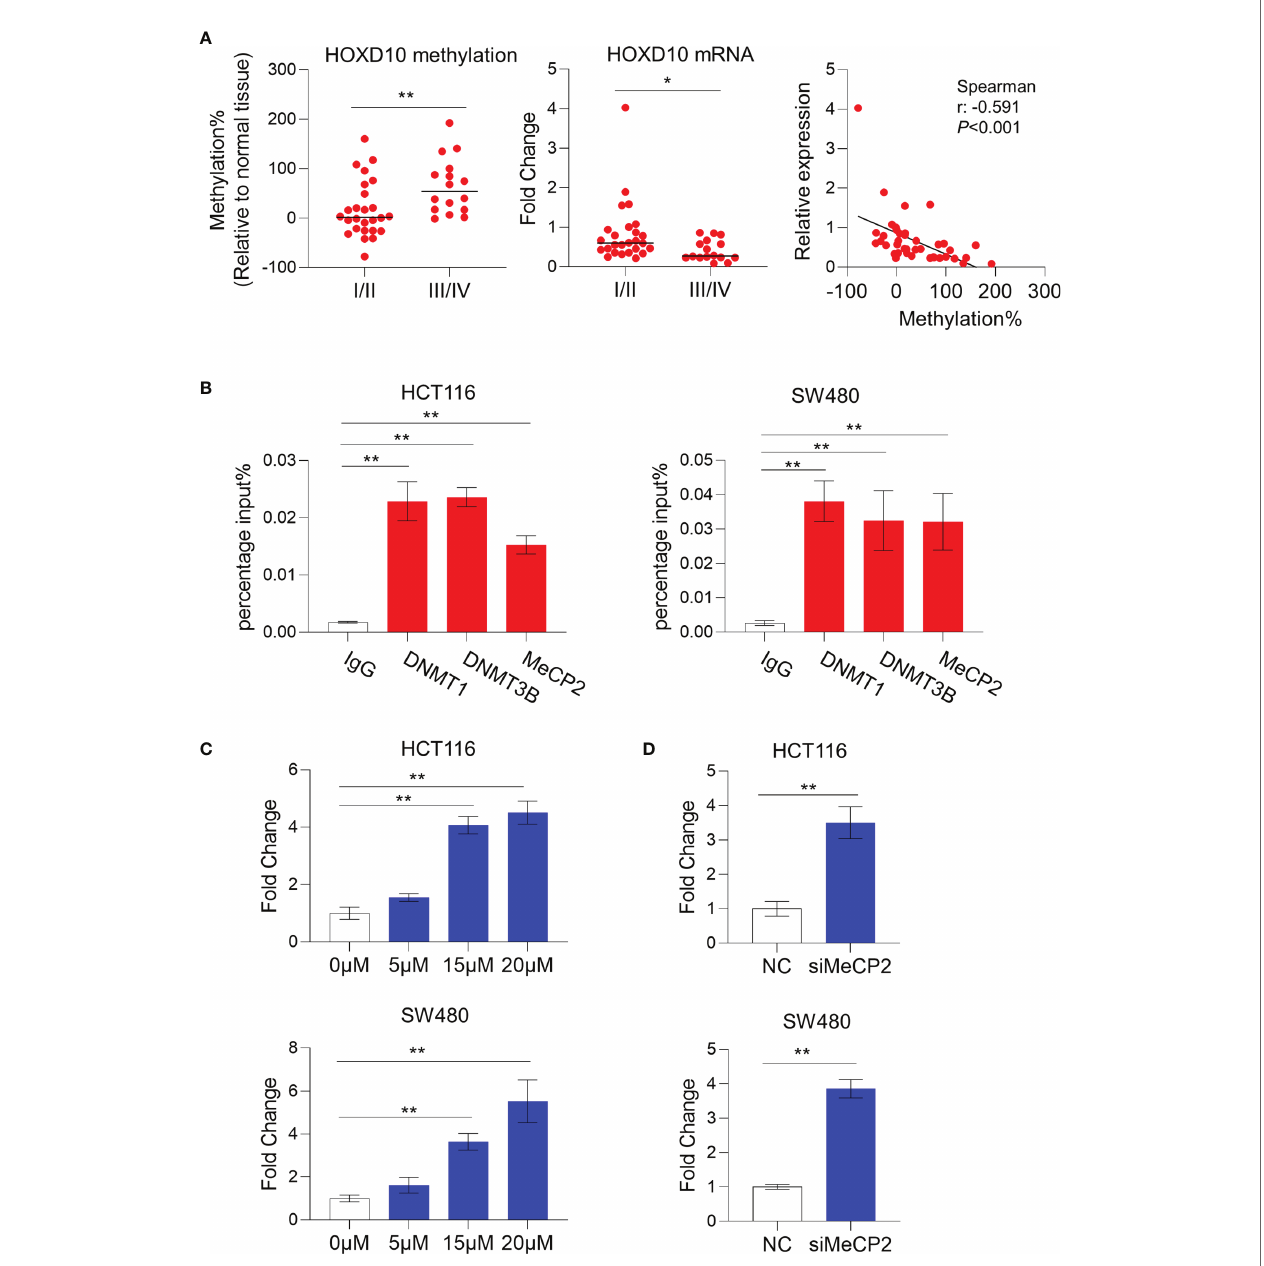
FIGURE 2 | HOXD10 methylation correlated with its low expression incolorectal cancer. (A) The relative methylation and mRNA levelsof HOXD10 were demonstrated. Patients with advanced stage (III/IV) cancer hada higher level ofmethylation, but a lower expression level,compared to those with early stage (I/II) cancer.* p < 0.05, ** p < 0.01 (Mann – Whitney test). Correlation analysis was also performed andshowedthat HOXD10 methylation was negatively associated with its expression level. (B) Chromatin immunoprecipitation quantitativePCR (ChIP-qPCR)assay revealed a signi fi cant enrichment ofDNMT1, DNMT3B, and MeCP2 observed inthe HOXD10 promoter region in the colorectalcancer celllines HCT116 and SW480. ** p < 0.01 (independent t -test). (C) HCT116 and SW480 cellswere treated with the DNA methyltransferase (DNMT) inhibitor 5-Aza-2 ′ -deoxycytidine (5-Aza-CdR) atconcentrationsranging from0 to 20 m M.The expression of HOXD10 was then evaluatedby qPCR.** p < 0.01 (ANOVA test). (D) The expression of HOXD10 was examined in HOXD10 -expressing cells and control cells using qPCR.** p < 0.01 (independent t